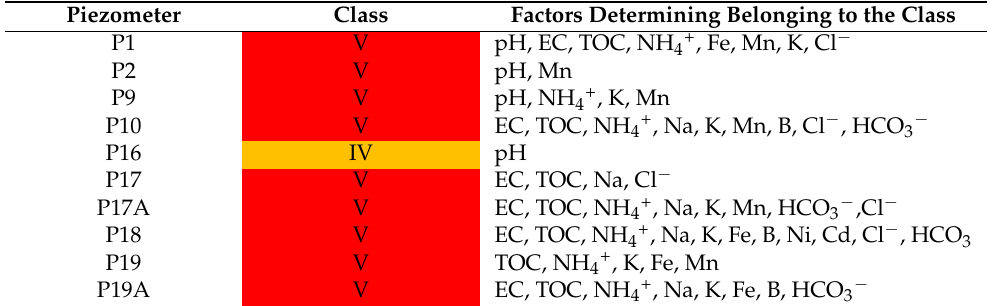
Table 3. Water quality classes determined on the basis of data from